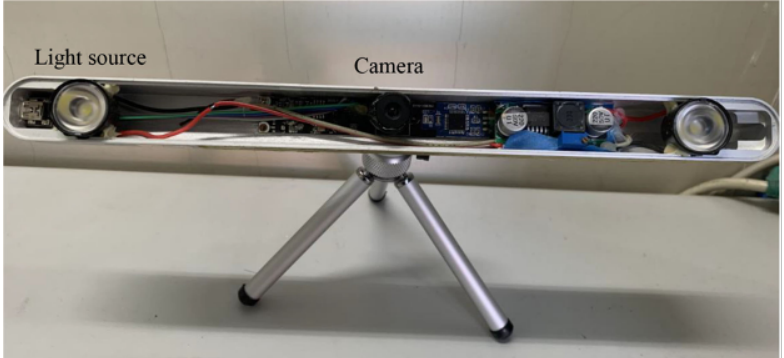
Figure 9. Experimental